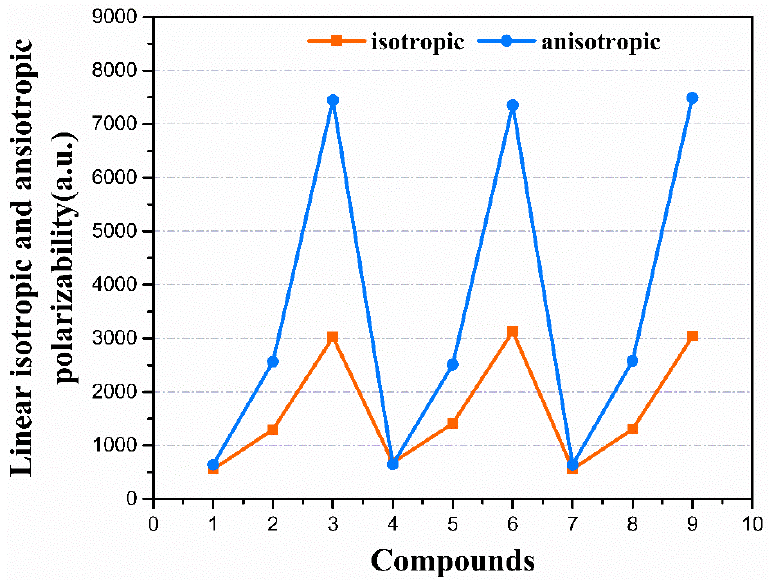
Figure 3. The linear isotropic ( α iso ) and anisotropic ( α aniso ) polarizability.